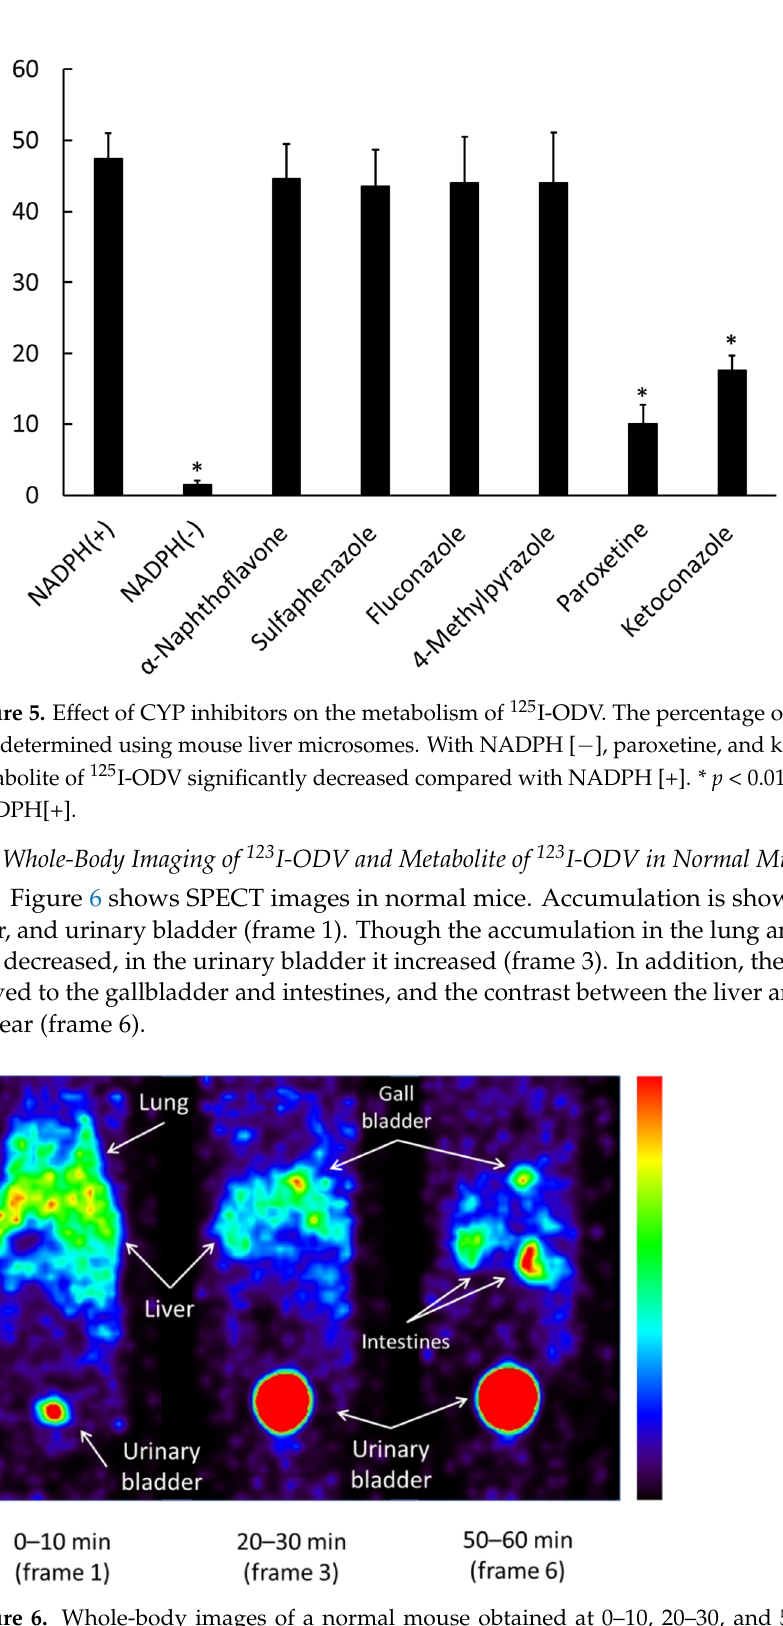
Figure 6. Whole-body images of a normal mouse obtained at 0–10, 20–30, and 50–60 min after 14.5 MBq 123 I-ODV injection under 1.5% isoflurane anesthesia. Depending on the time, the accumulation in lung and liver decreased, and the accumulation in the gallbladder became clear. In addition, increased accumulation in the intestines and urinary bladder indicated that excretion was